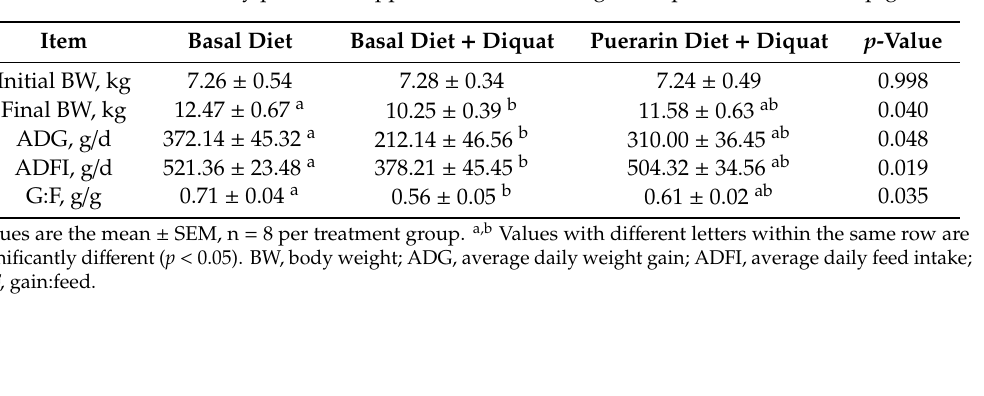
Table 2. E ff ects of dietary puerarin supplementation on the growth performance of the